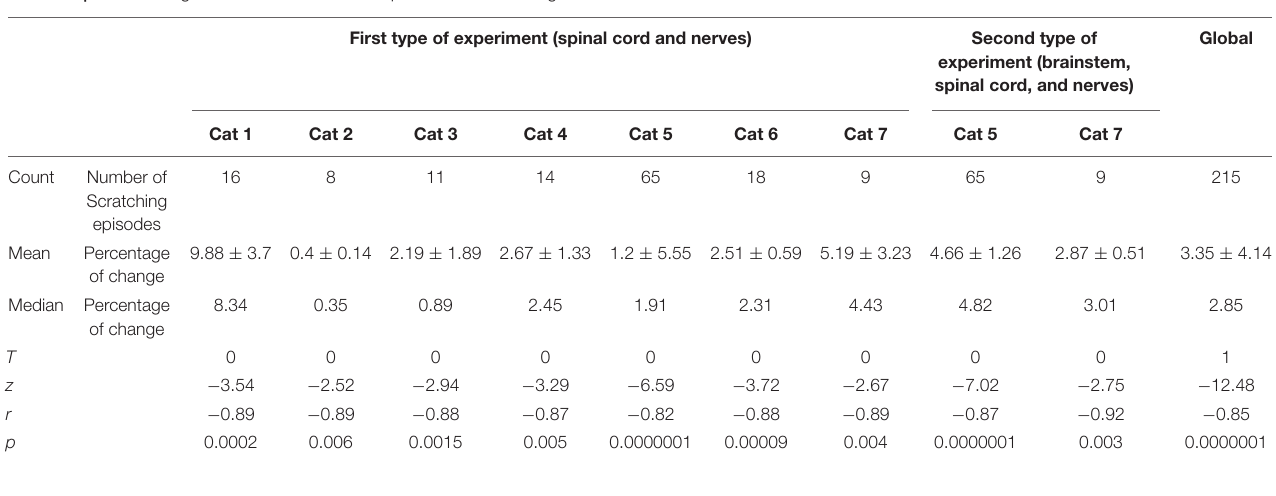
FIGURE 3 | Correlations between the functional DC-PPG in the brainstem and the spinal cord versus the summated motor response during episodes of motor action. (A) Diagram of the experimental arrangement. Two Texas Instruments OPT-101 photodiodes were positioned on the brainstem and spinal cord to obtain simultaneous recordings of the functional DC-PPG signals (blue traces) during the motor action (black traces). The magenta histogram illustrates the latencies between the maximal points (red triangles) of the DC-PPG signal in the obex and the DC-PPG signal in the spinal cord. The blue histogram illustrates the latencies between the maximal point (red triangle) of the DC-PPG signal in the spinal cord and the mean interval of the summated TA and MG motor responses (red triangle). (B) Normalized data of the correlation between the obex PPG signal and the electroneurographic TA + MG signal. (C) Normalized data of the correlation between the spinal PPG signal and the obex PPG signal. (D,E) The same as panels ( B,C ), but for another animal. (F,G) Histograms of the percentage of change of the obex and spinal PPG signals for all the animals, as indicated (see also Table 1 ). TABLE 1 | Statistical significance of normalized amplitude of DC-PPG